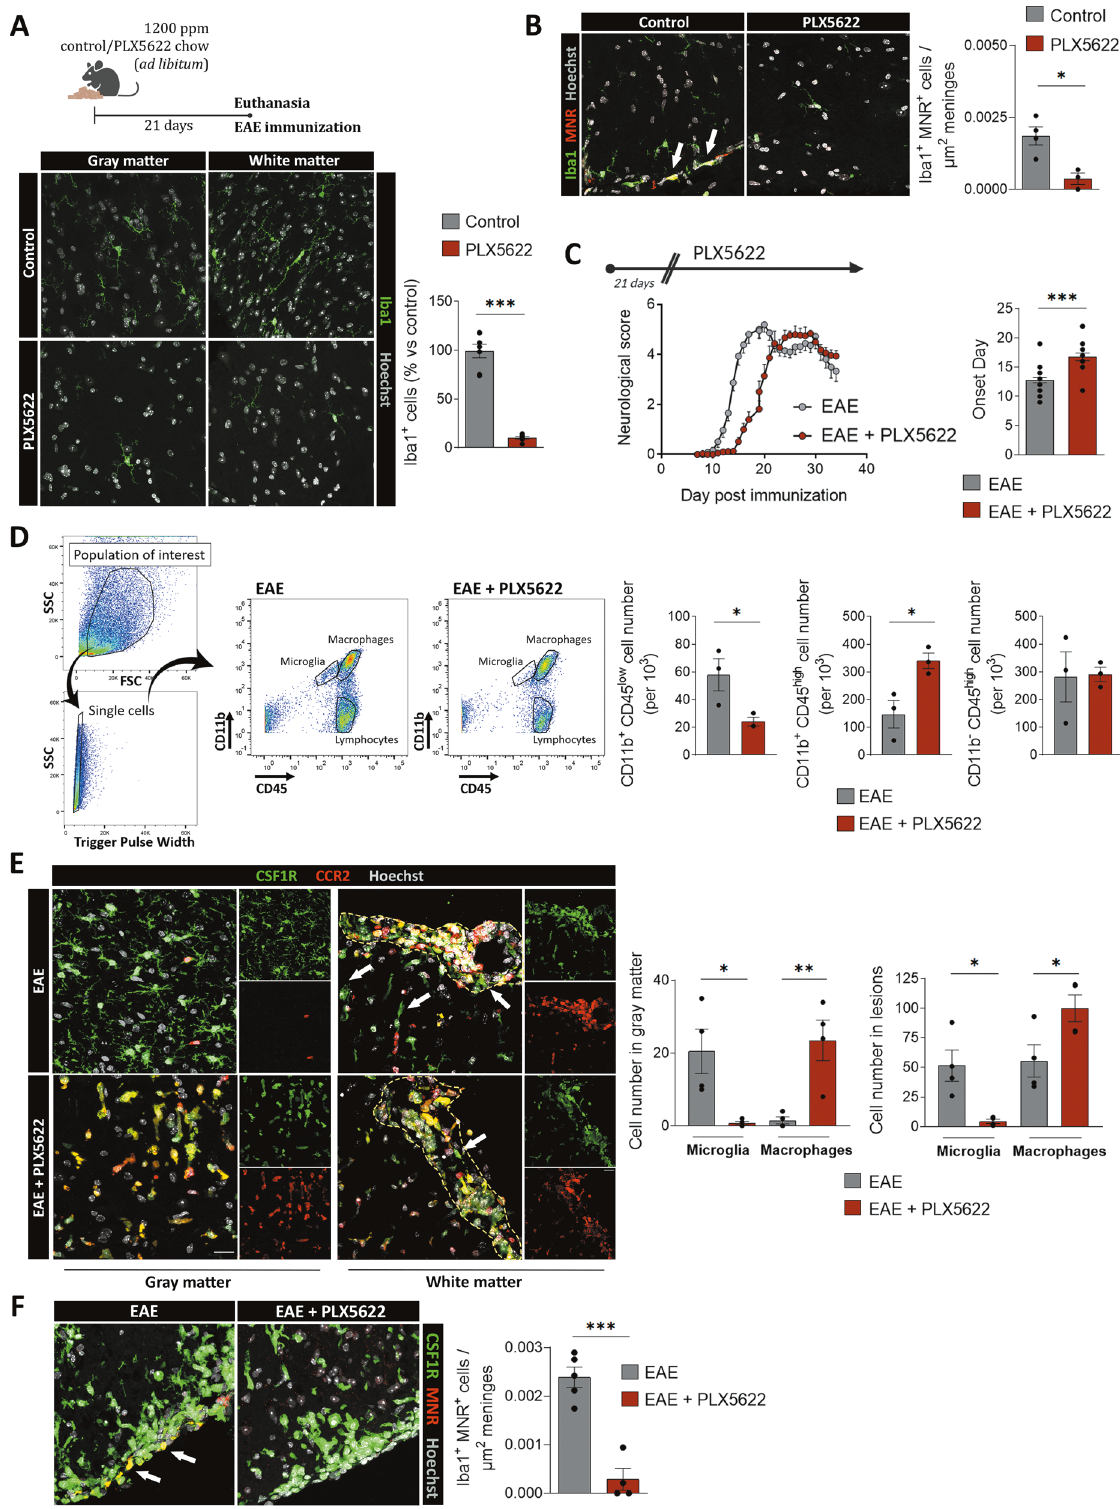
proportion of CD4 + T cells, CD8 + T cells, γδ T cells, neutrophils or macrophages/monocytes neither in the spleen nor in the blood (Fig. 3B, C). Taking advantage of the blood sampling, we analyzed the concentration of pro- and anti-in fl ammatory cytokines in the